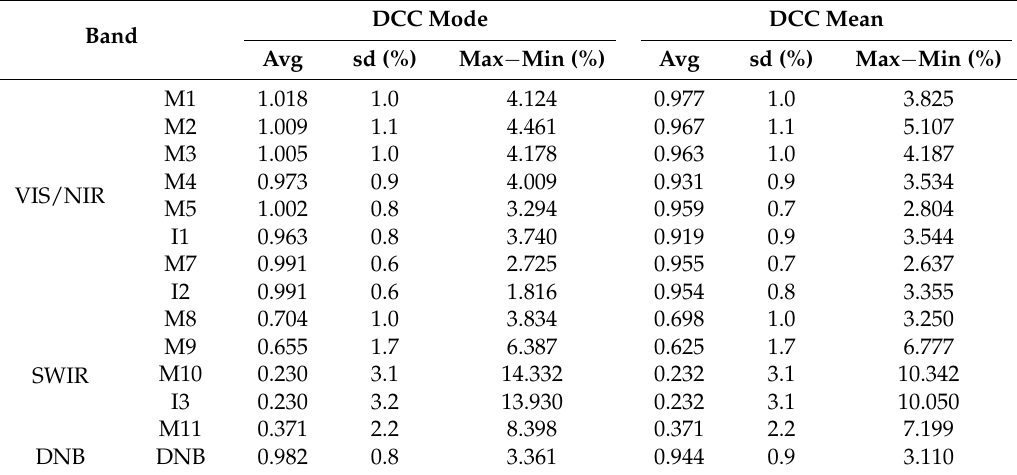
Table 2. Statistics of monthly DCC Top of Atmosphere (TOA) reflectance (before the ADM